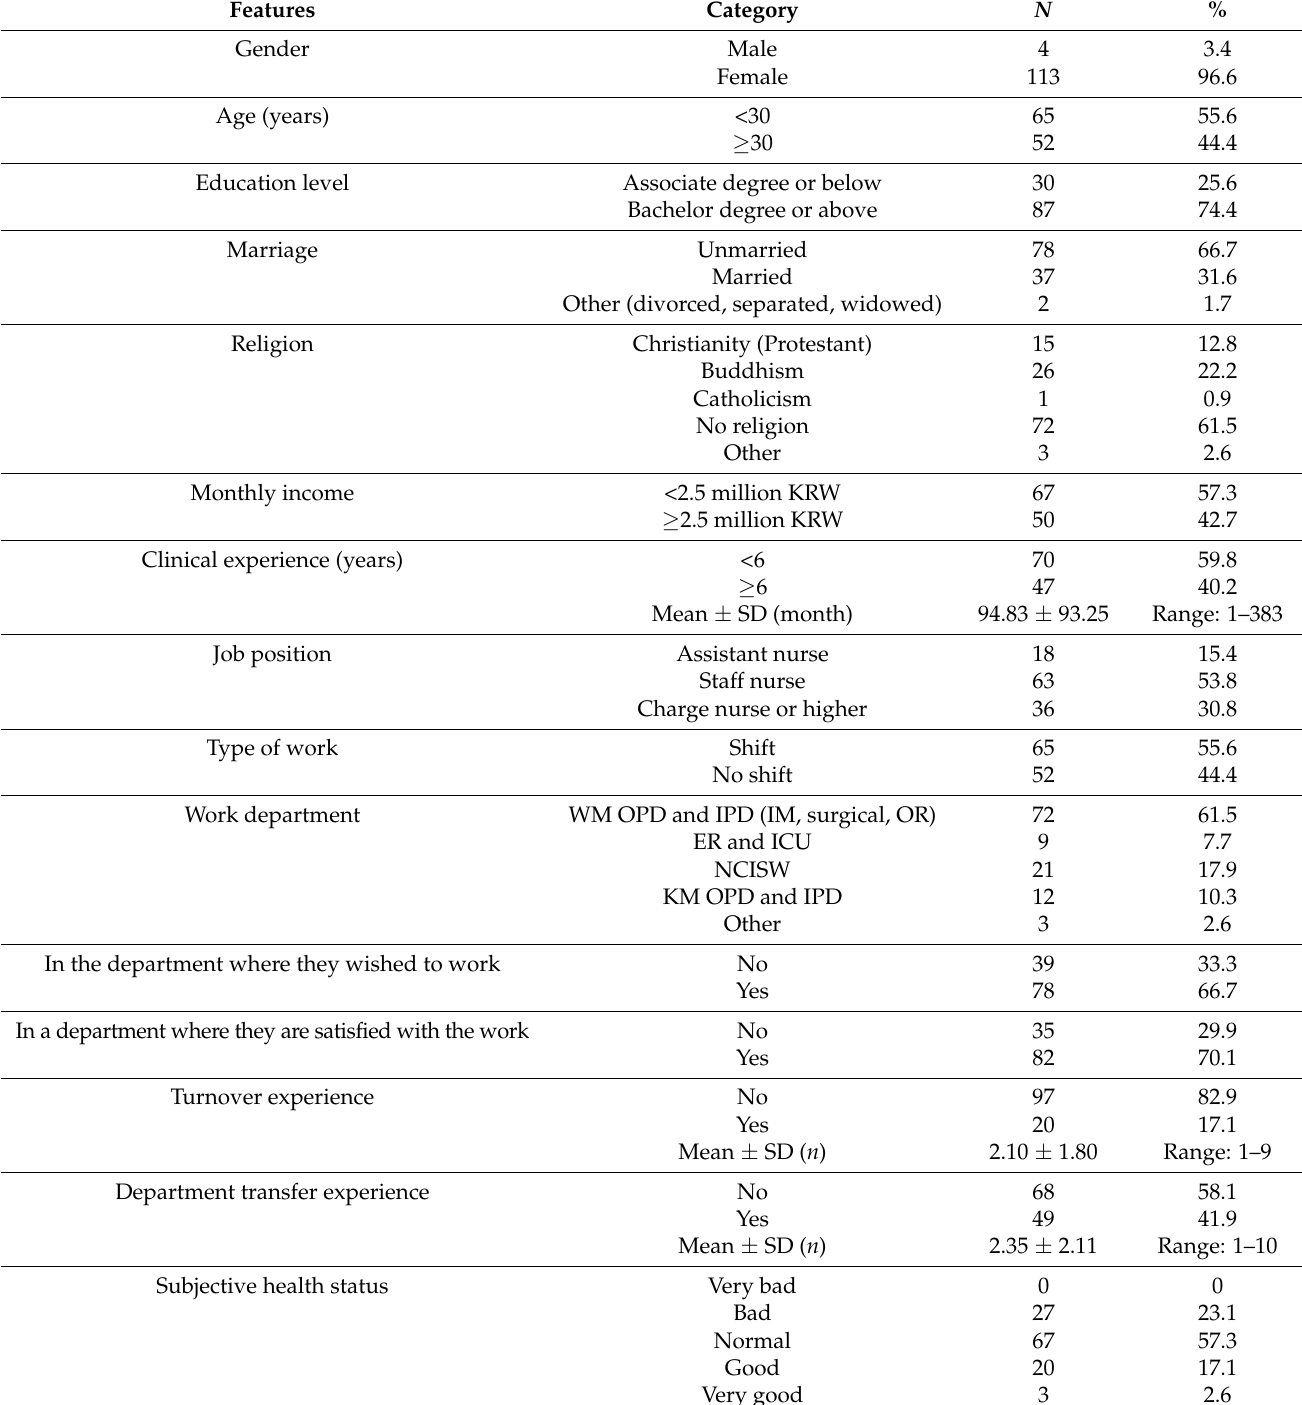
Table 1. Demographic characteristics of participants ( N =